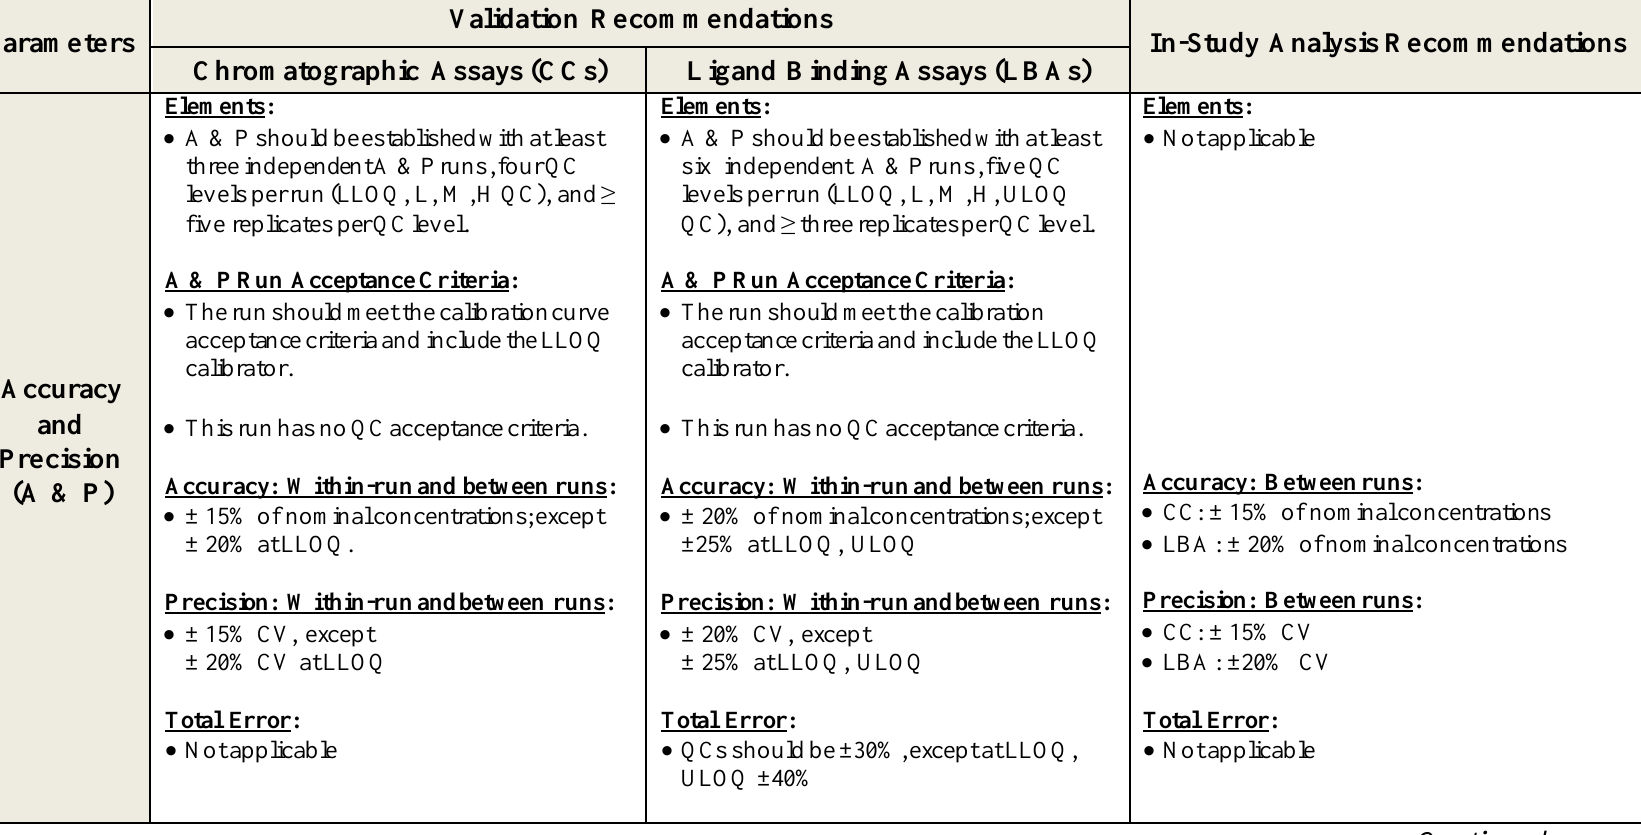
Table 1 continued. Recommendations and Acceptance Criteria for Bioanalytical Method Validation and In-Study